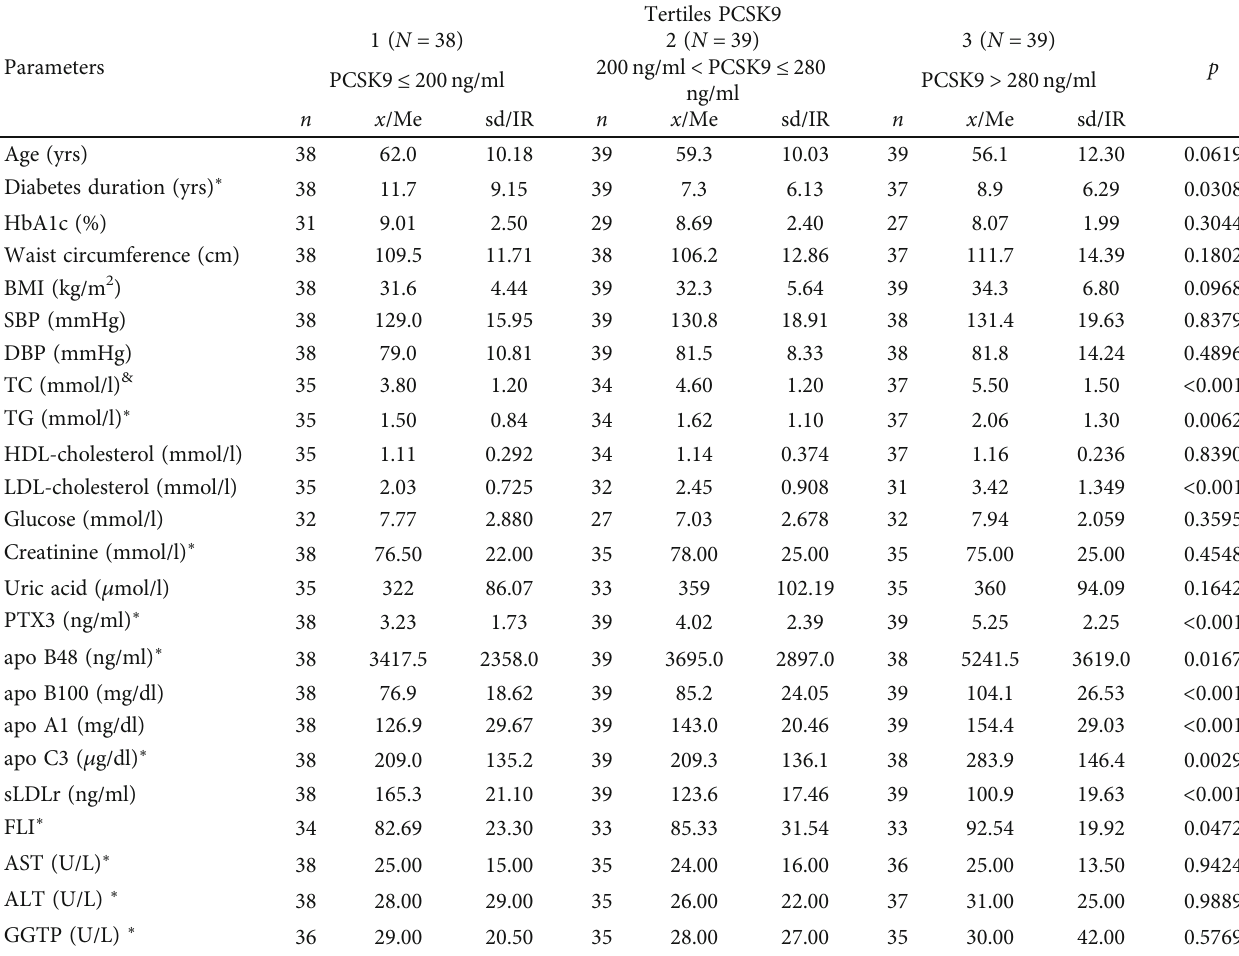
Table 2: Characteristics of examined variables according to PCSK9 tertile